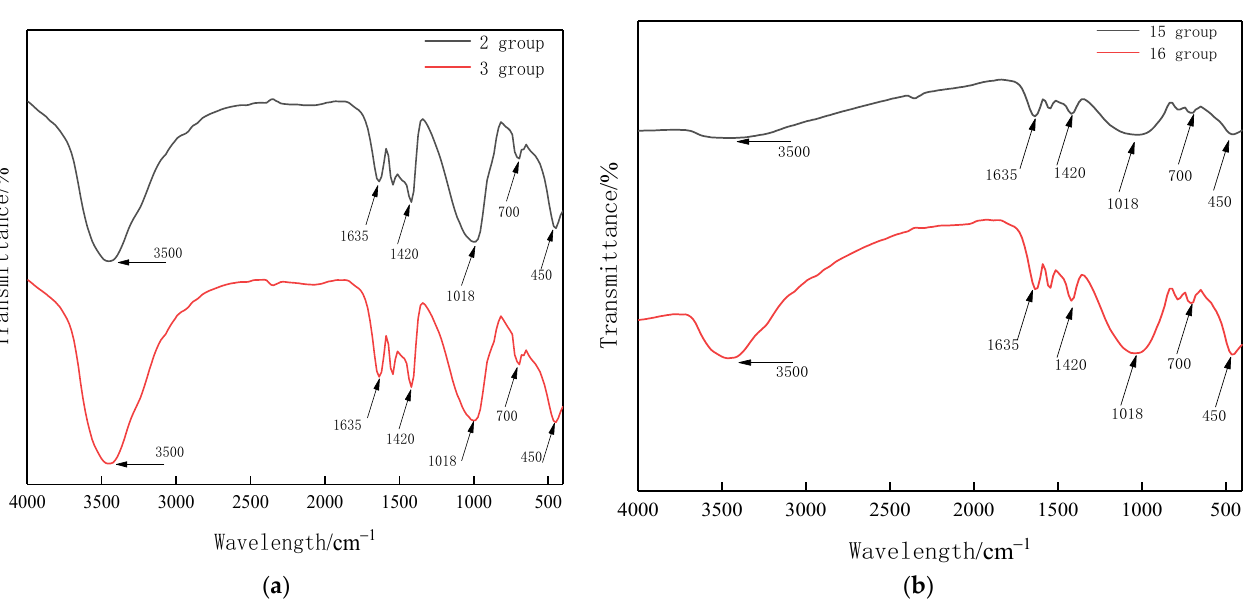
Figure 8. FTIR images of the 2nd, 3rd, and 15th, 16th groups of the composite gelling system. ( a ) 2 and 3 groups, ( b ) 15 and 16 groups .